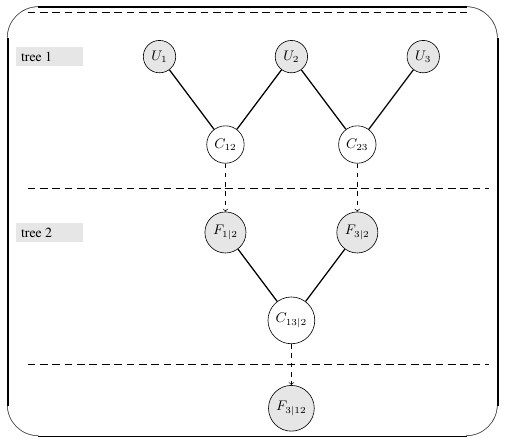
Figure 1. Hierarchical nesting of bivariate copulas in the construc- tion of a 3-dimensional vine copula through conditional mixtures.